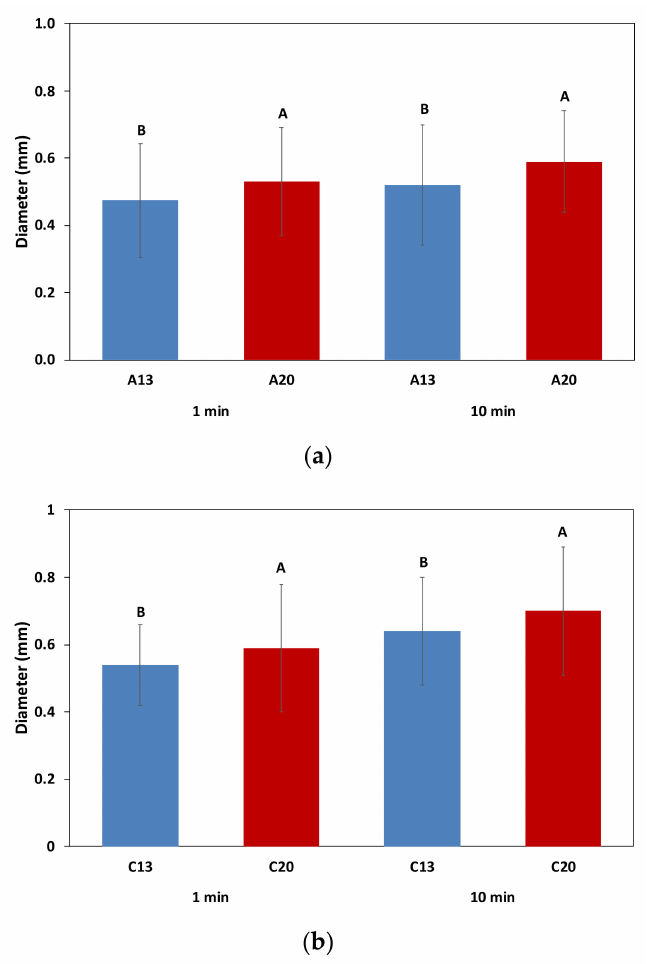
Figure 5. Average diameter of bubbles in the foam collar from the six wine samples, measured at 1 and 10 min after the end of pouring. ( a ) Wine samples A and ( b ) wine samples